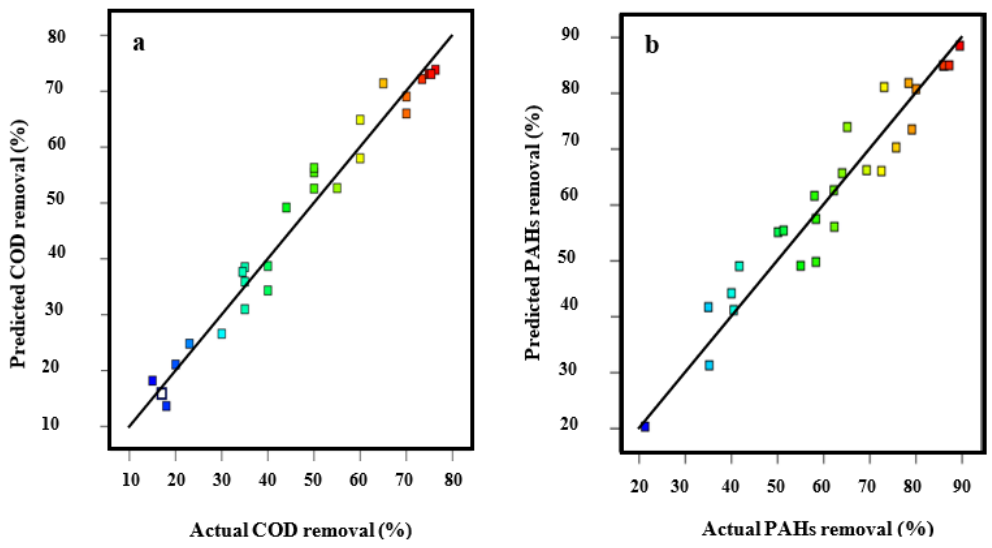
Figure 4. Predicted vs. actual removal (%); ( a ) COD removal, and ( b ) PAHs removal.